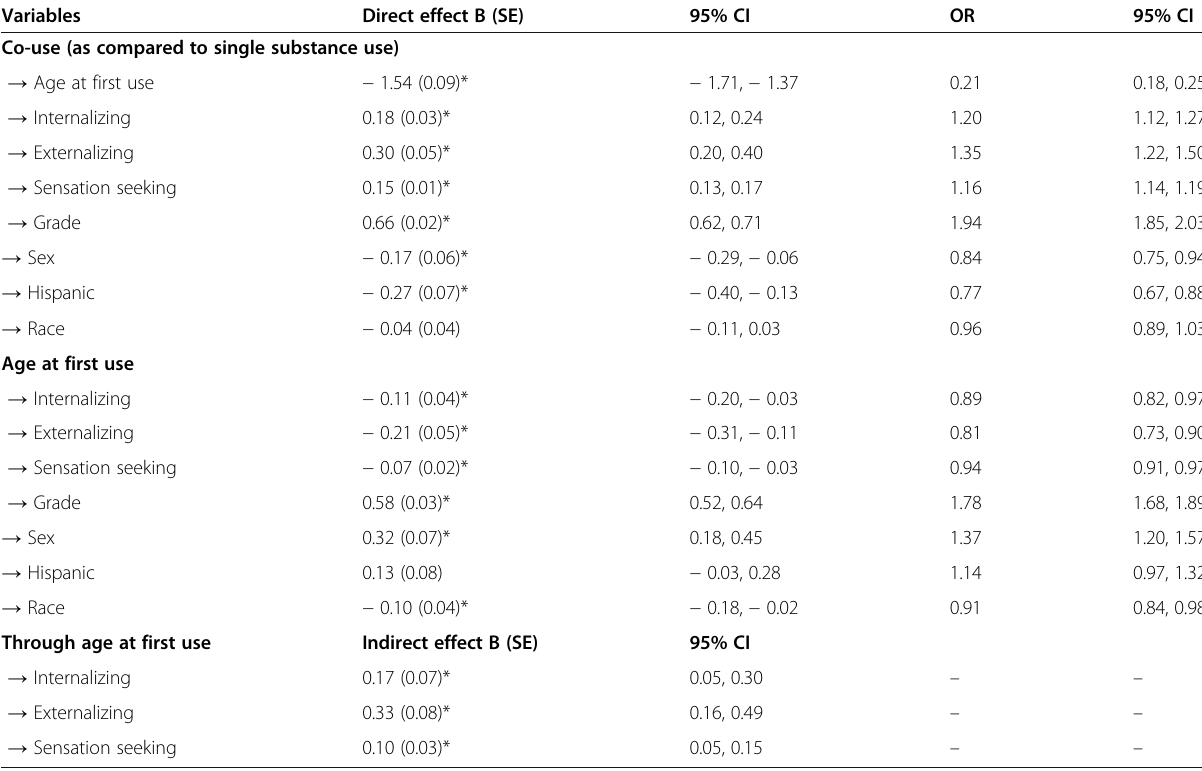
Table 3 Direct and specific indirect effects of youth demographics, psychological constructs of sensation-seeking, internalizing, and externalizing, and age at first use on lifetime tobacco and cannabis use status Variables